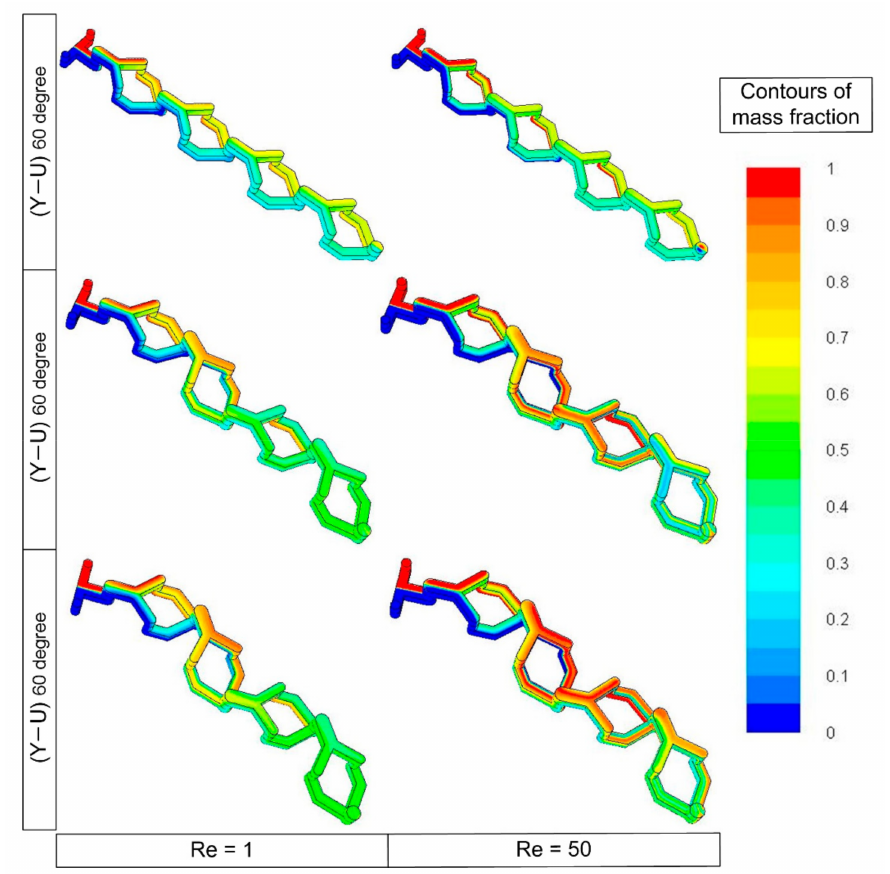
Figure 10. Mass fraction of liquid inside the ( Y − U ) micromixers at Re = 1 and Re = 50. β Figure 11 expresses the relationship between pressure drops or mixing cost and Reynolds numbers for ( Y − U ) and H − C micromixers. Pressure drop shows a positive β relationship with Reynolds numbers for all mixers. Pressure drop does not depend on angle β because all ( Y − U ) mixers have the same length and physical dimensions. More- β over, the ( Y − U ) micromixers offer 3.5 times less pressure drop compared to the H − C β